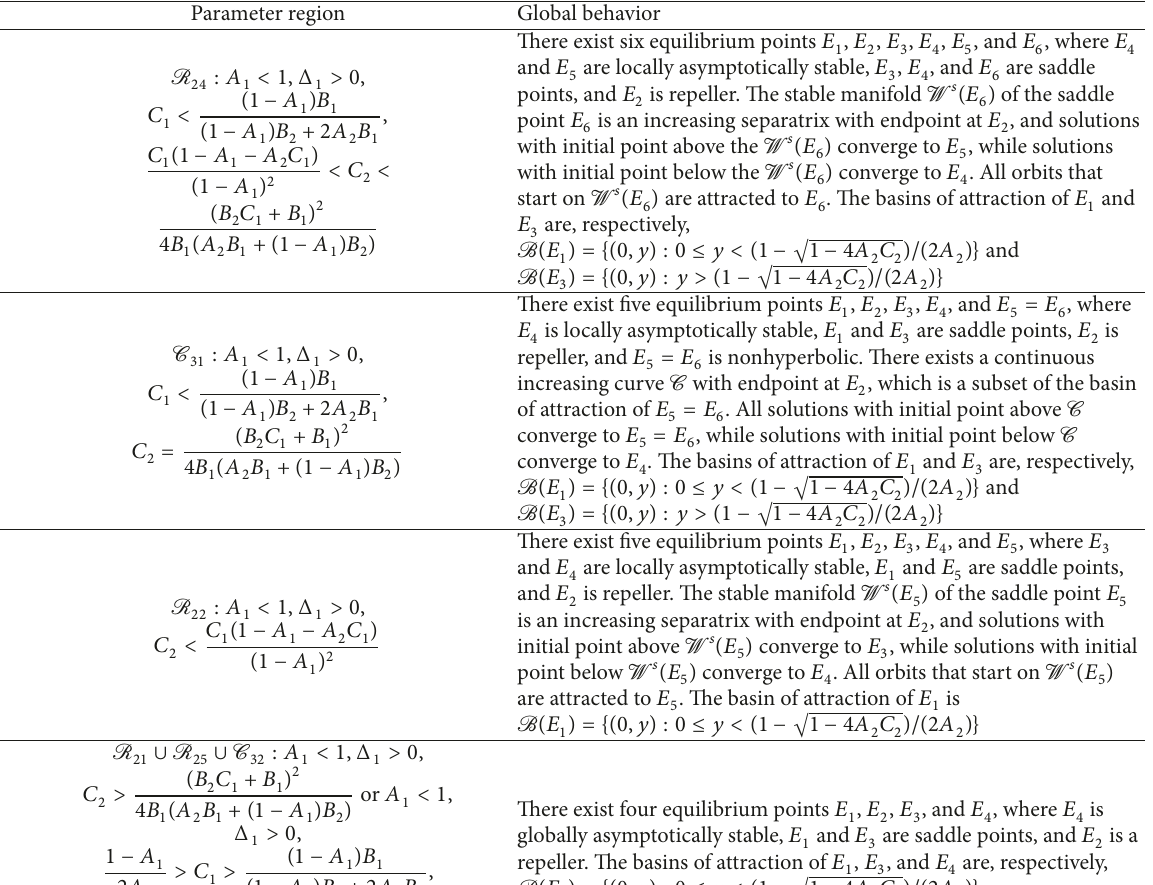
Table 3: The global behavior of system